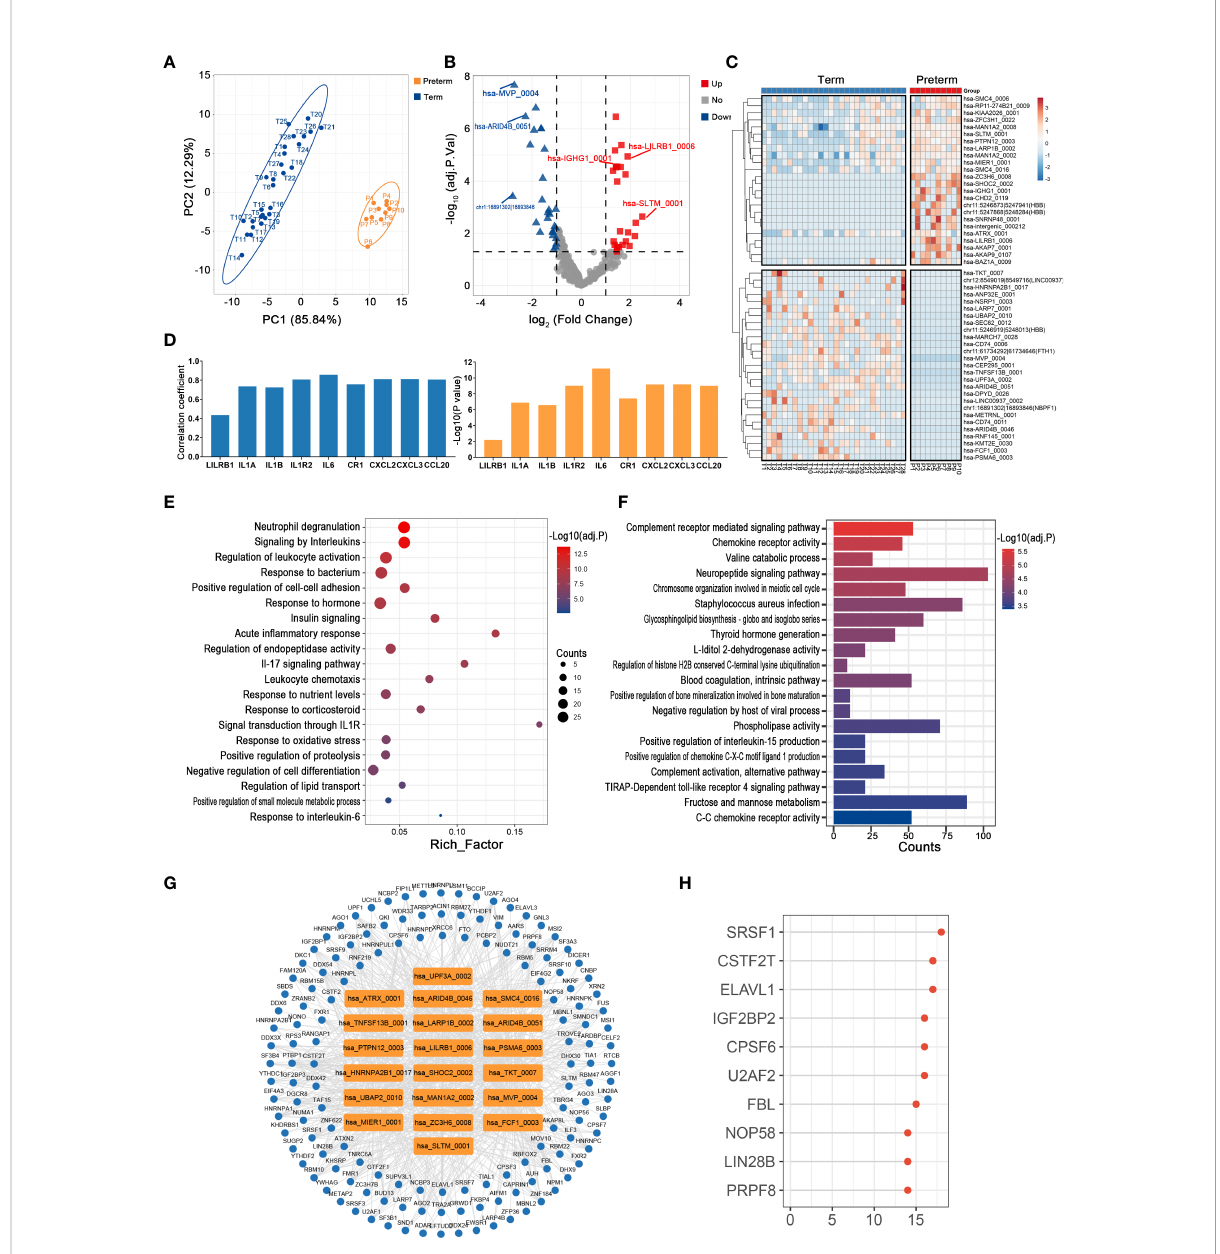
FIGURE 3 The circRNA changes and functional analyses in maternal monocytes of PTB. (A) PLS-DA of circRNA expression in preterm (yellow points) and term (blue points) maternal monocytes. (B) The volcano plot of circRNA changes and adj. p-values in maternal monocytes of PTB. (C) The hierarchical clustering of DECs expression in term and preterm maternal monocytes. (DECs: |log2 (fold change)|> 1 and adj. p-value < 0.05). (D) Correlation coef fi cients and P values for hsa-LILRB1_0006 and its host gene and several immune in fl ammatory factors. (E, F) Functional enrichment analysis for co-expressed mRNAs (E) and target miRNAs (F) of DECs in preterm maternal monocytes. (G, H) The DECs-RBPs network and top 10 RBPs in maternal